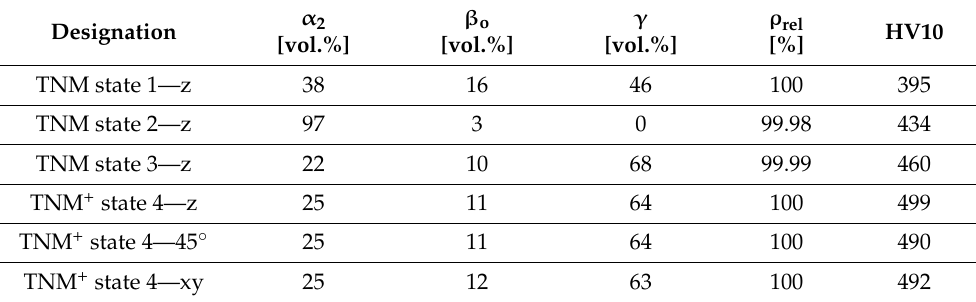
Table 3. Phase fractions established by XRD for the TNM alloy (state 1, 2 and 3) as well as the TNM + alloy (for the three different geometries z, 45 ◦ and xy, in state 4) after procedure 1 and 2 (see Figure 2a,b). In addition, the relative density ρ rel and the Vickers hardness are